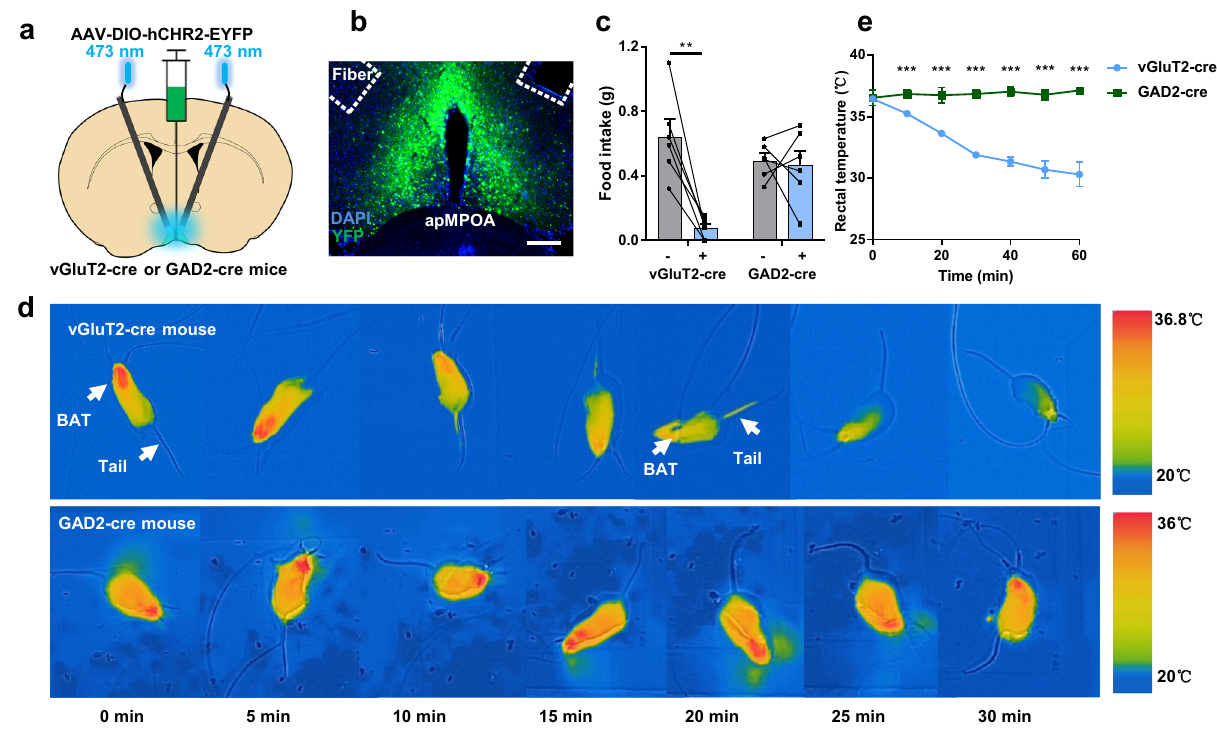
Fig. 2 Opto-stimulation on glutamatergic apMPOA neurons induces decreases in food intake and rectal temperature. a , b Schematic and representative coronal images of injecting AAV virus expressing ChR2 into the apMPOA in vGluT2-cre and GAD2-cre mice and oblique optical fi ber implantation above the apMPOA. Image representative of n = 10 mice. Scale bar, 100 µ m. c Opto-stimulation (2h) on the apMPOA neurons in vGluT2-cre mice decreased food intake, but not in GAD2-cre mice. Paired t tests (two-sided), ** p = 0.003, n = 6 animals for each group (a total of 10 mice models were made, and 4 mice for each group were excluded due to missed injections or death). d Infrared thermography revealed that opto-stimulation (30min) on the apMPOA neurons in vGluT2-cre mice, but not GAD2-cre mice, promoted tail heat dissipation and inhibited BAT thermogenesis. e Opto-stimulation (60min) on the apMPOA neurons in vGluT2-cre mice induced transient rectal temperature decrease (record 60min for 7 time points), but not in GAD2-cre mice (Rectal temperature of vGluT2-cre mice was signi fi cantly lower than that of GAD2-cre mice at the points 2-7, all *** p <0.001). ANOVA interaction effect: F(6, 5) = 34.45,*** p <0.001; main effect of time: F(6, 5) = 30.45,*** p < 0.001; main effect of group: F(1, 10) = 641.33,*** p < 0.001. Within-group tests showed signi fi cant simple effect of time in vGluT2-cre group (F(6, 5) = 64.14, *** p < 0.001), but not in the GAD2-cre group (F(6, 5) = 0.77, p = 0.63). Two-way repeated-measure ANOVA, n = 6 animals for each group. All error bars show (Supplementary Fig. 4k-l, Supplementary Movie 4). The DMH